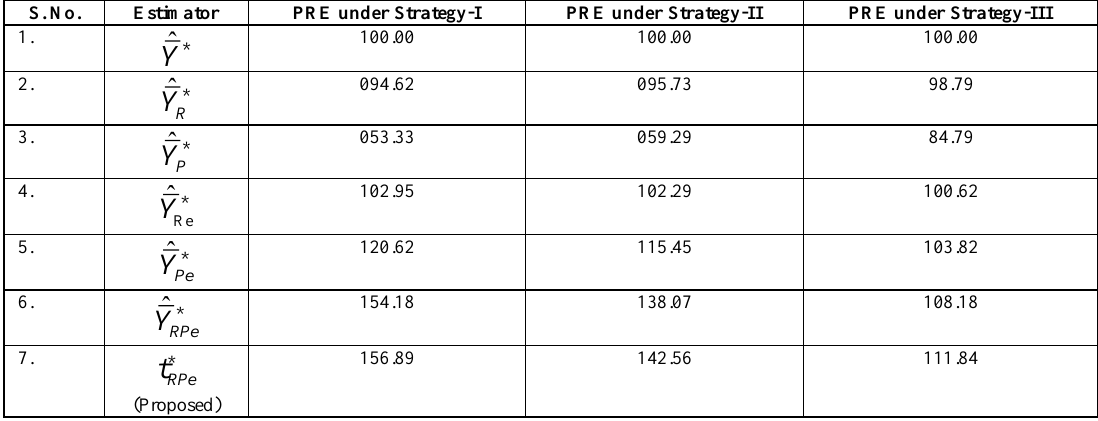
Table 8. PRE of various estimators with respect to the mean per unit estimator for the Population-I S.